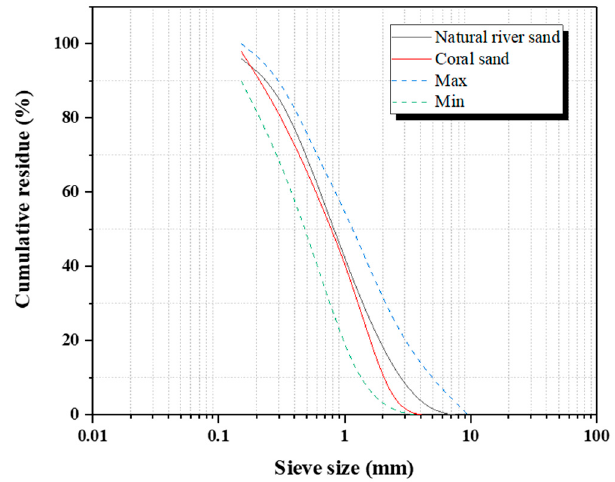
Figure 1. Particle size distribution of the natural river sand and coral sand.